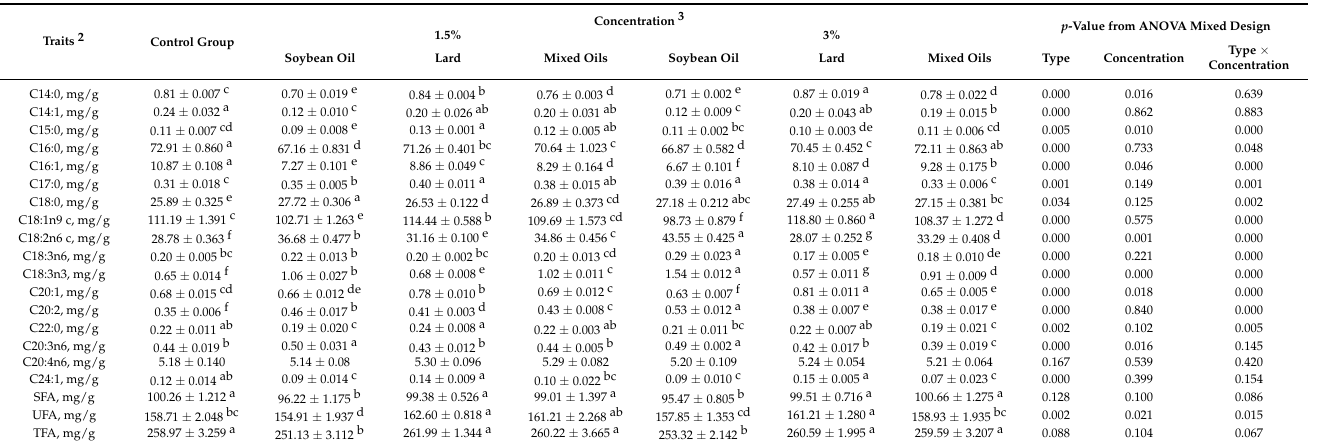
Table 5. Effects of different concentrations of soybean oil, lard, and mixed oils on fatty acids of raw egg yolk 1